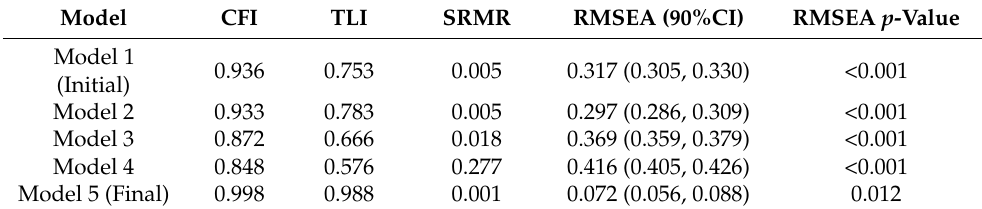
Table 2. Summary of model fit indices for all the models (Models